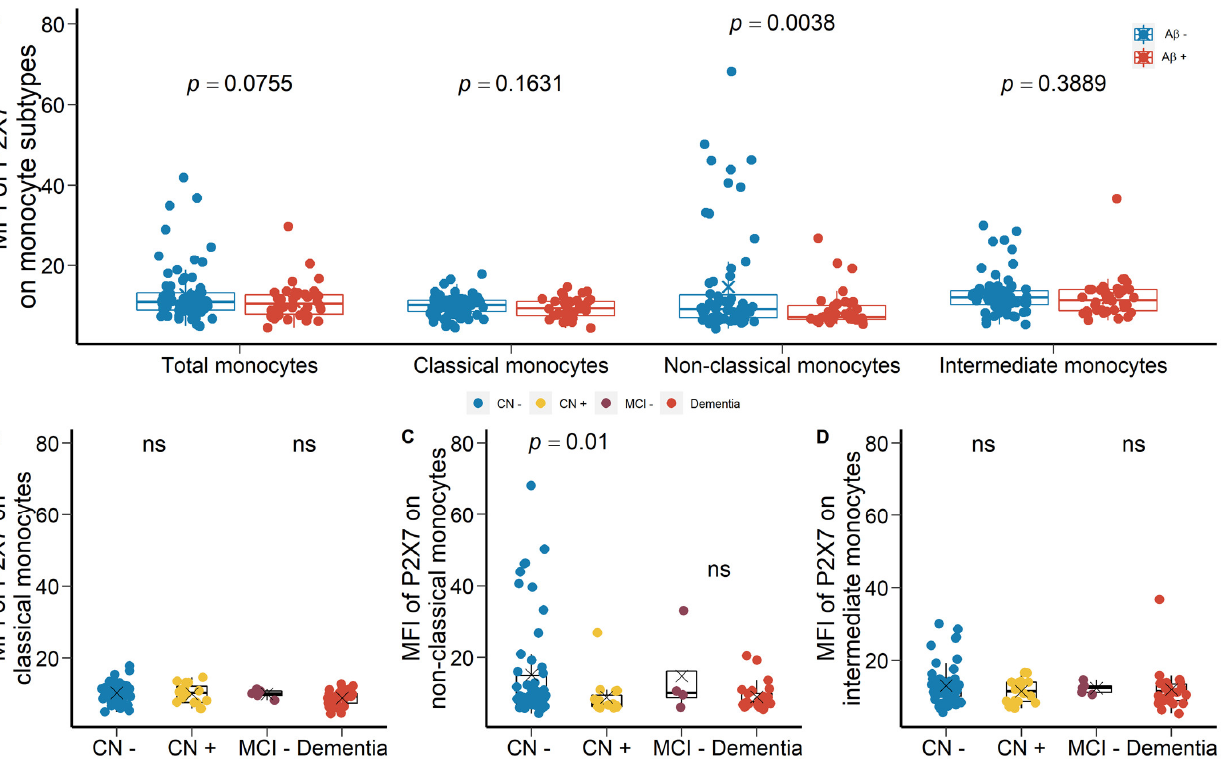
Figure 5. P2X7 expressions on monocytes in the validation cohort A. ( A ) P2X7 expressions on total monocytes ( left 1 ), CD14 + CD16 − classical monocytes ( left 2 ), CD14 dim CD16 + non-classical monocytes ( right 2 ), and CD14 + CD16 + intermediate monocytes ( right 1 ) between Aβ −ve controls (Aβ−) and Aβ +ve cases (Aβ+). Two group comparison was determined by t -test. ( B – D ) Comparisons of P2X7 expressions on classic monocytes, non-classical monocytes, and intermediate monocytes between CN (CN−: CN −ve) and pre-clinical (CN+: CN +ve) individuals. Comparisons of P2X7 expressions on classic monocytes, non-classical monocytes, and intermediate monocytes between prodromal (MCI−: MCI −ve) and AD with dementia (Dementia: MCI +ve and AD) individuals. Two group comparison was determined by t -test. ns: no significance.